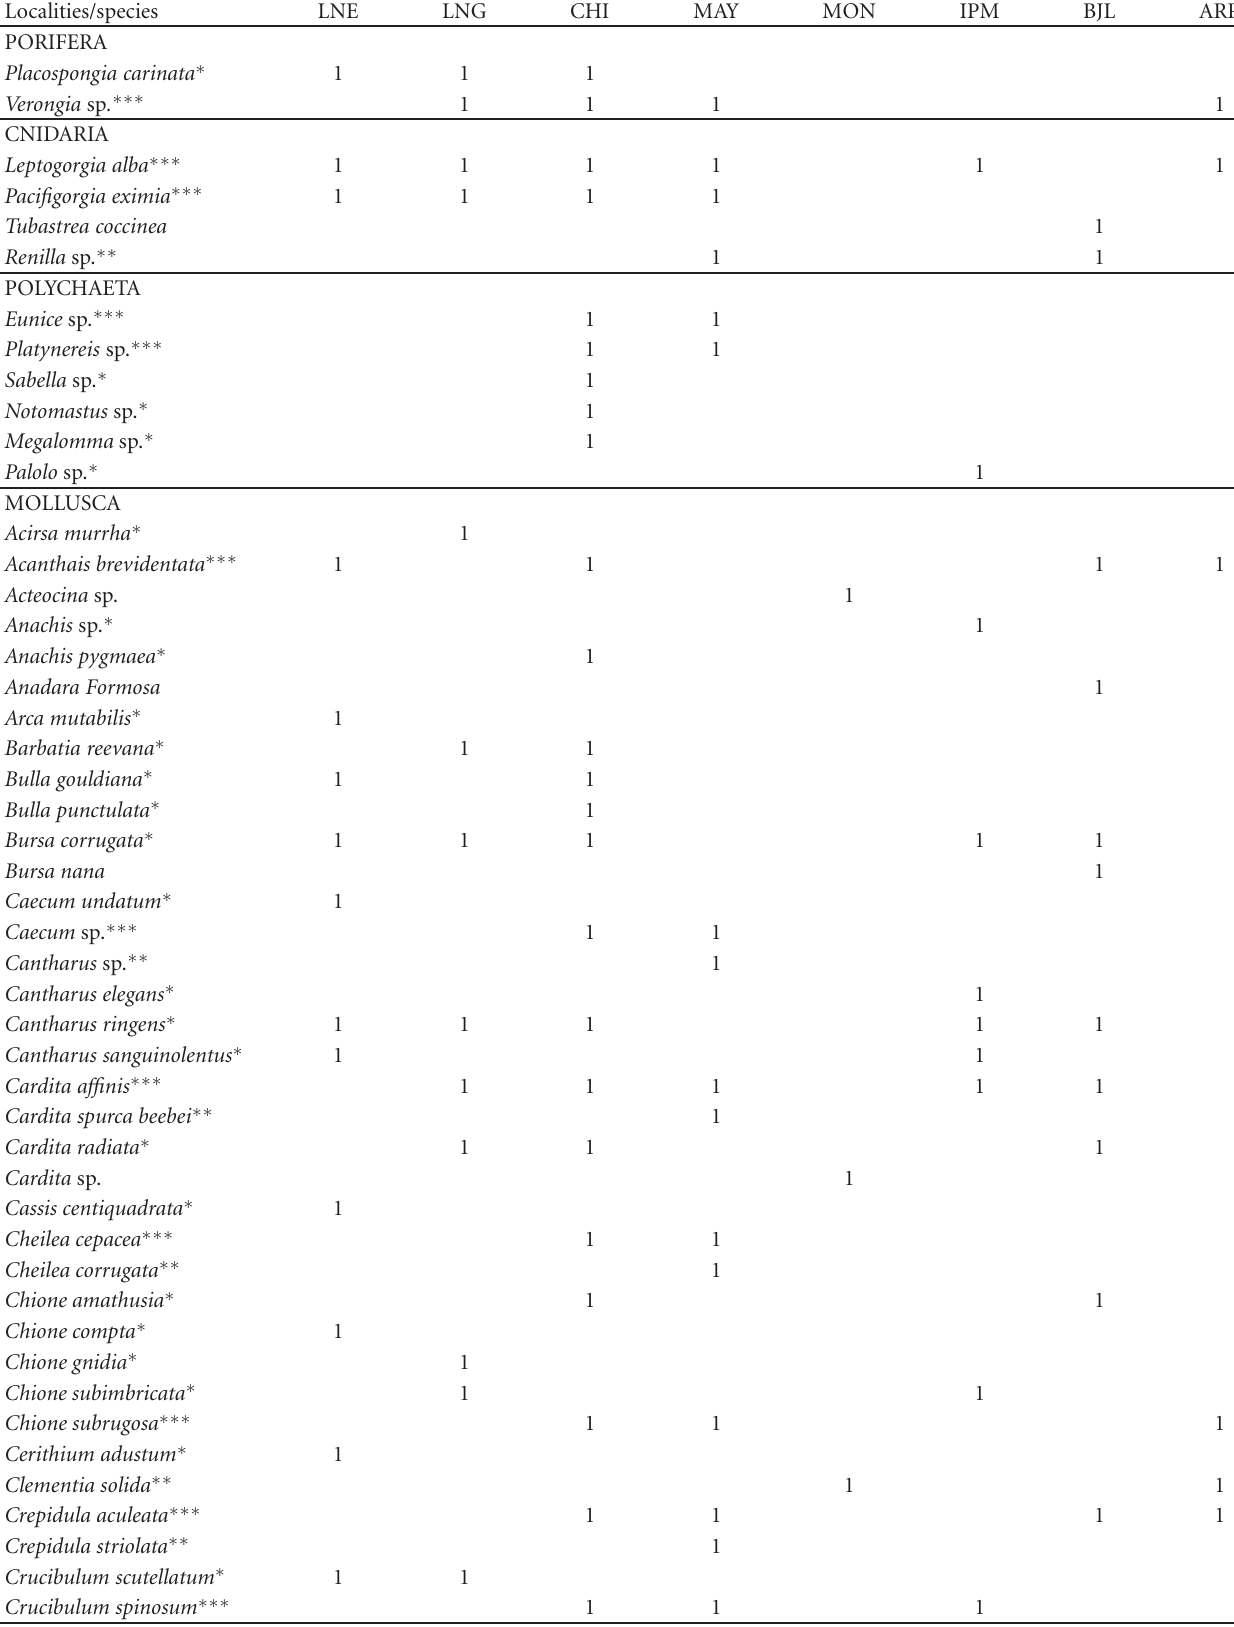
Table 5: ∗ Exclusive species of Group A. ∗∗ Exclusive species of Group B. ∗∗∗ Frequent species of Groups A-B. Localities/species LNE LNG CHI MAY MON IPM BJL